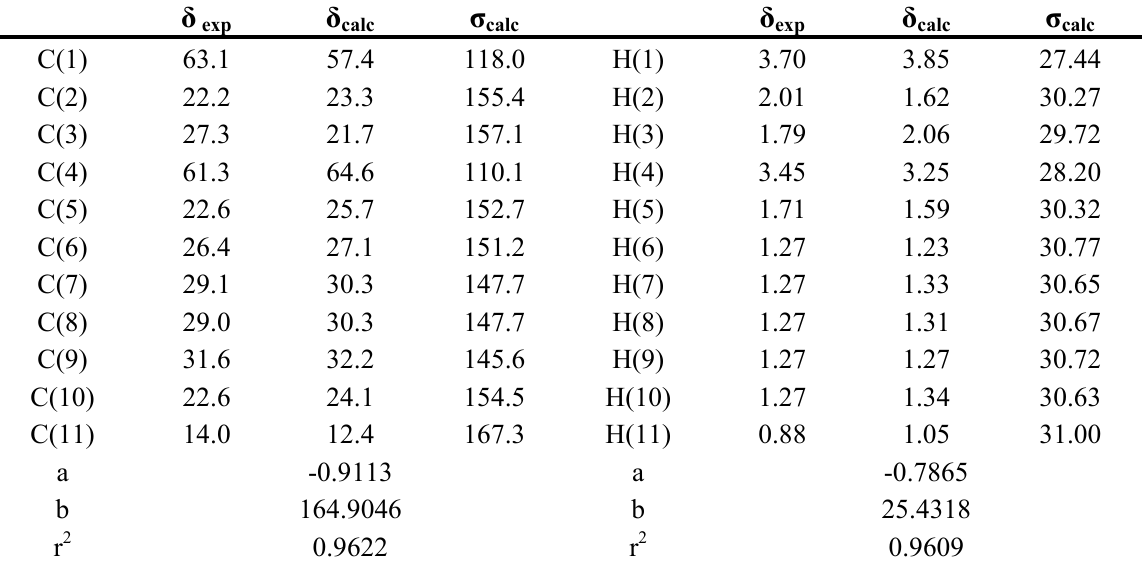
Table 3. Chemical shifts ( δ , ppm) in CDCl ) for N,N -dioctylazepanium bromide ( 1 ). The predicted GIAO chemical shifts shielding ( σ cal were computed from the linear equation δ fit the experimental